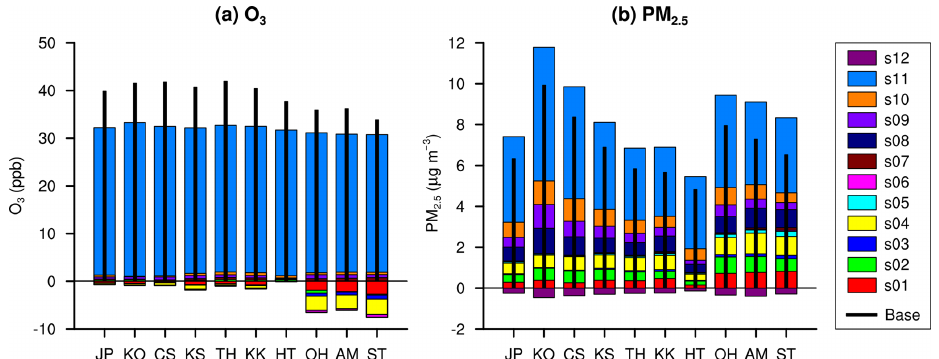
Figure 2. Source sensitivities of the annual mean ozone and PM 2 . 5 concentrations derived by BFM in the regions. Thick black lines represent the simulated